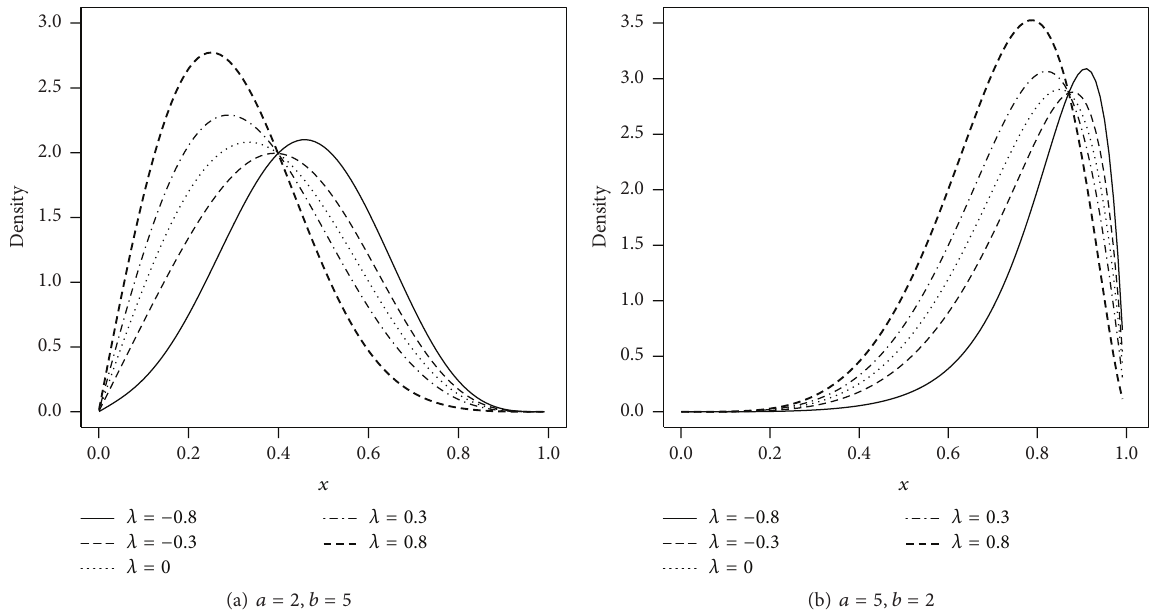
Figure 2: Plots of the TKw density function for some parameter